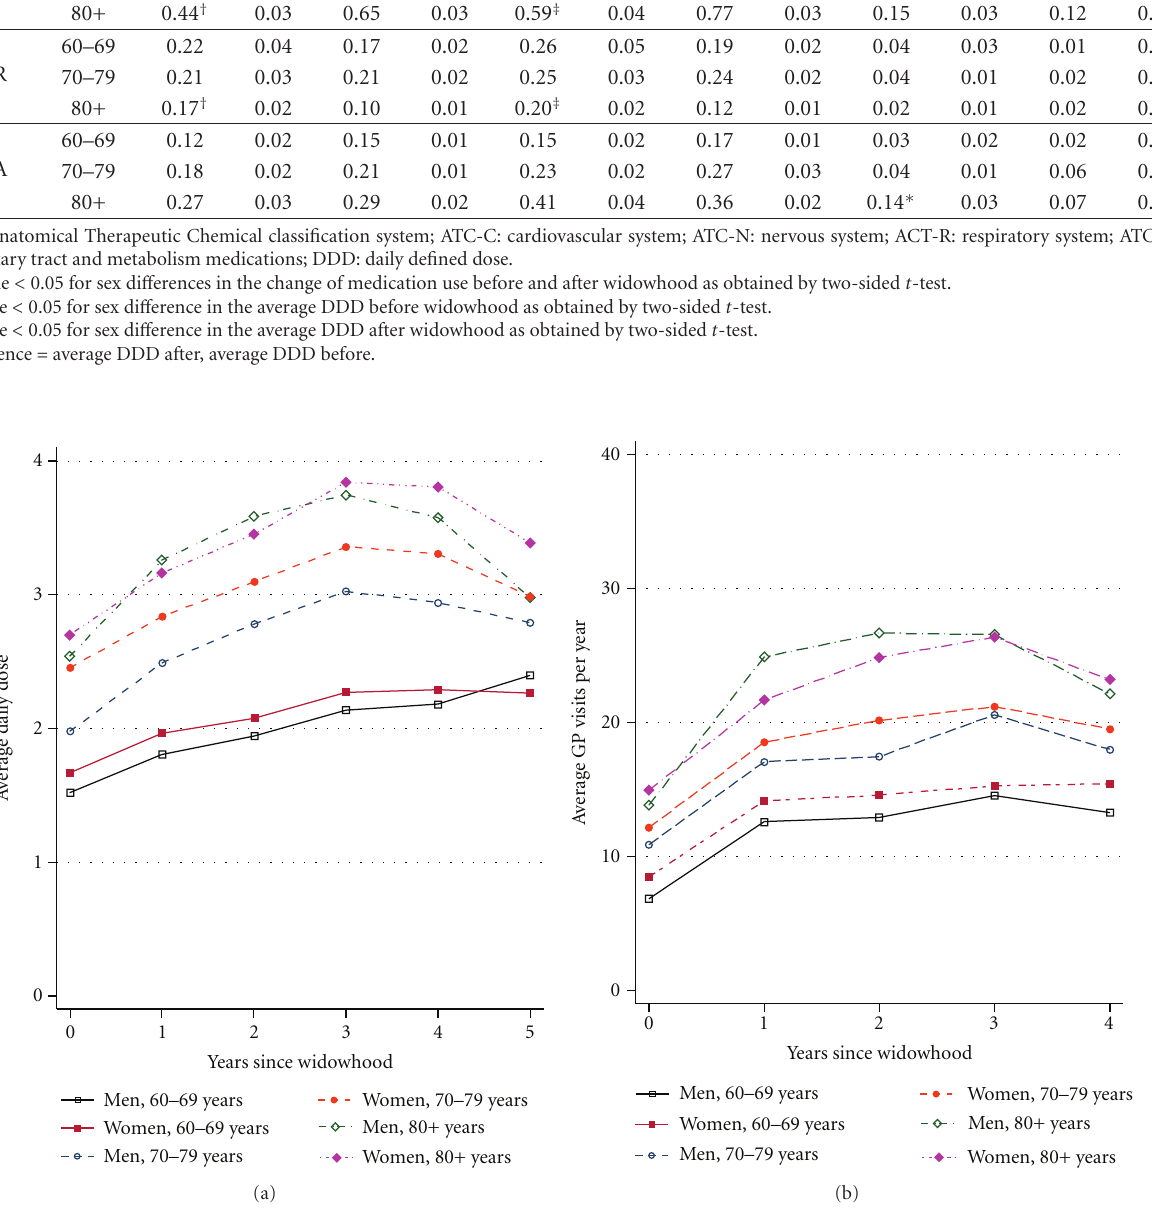
Figure 1: All-causes medication use and number of GP visits before and after